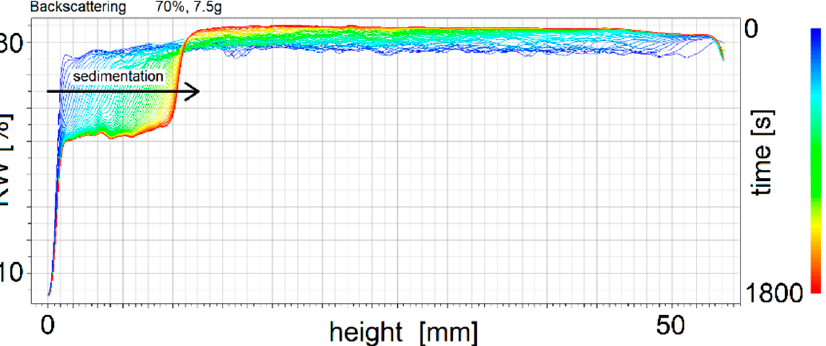
Figure 3. Changes in the backscatter signal over time as a function of test sample height for a 70% concentration emulsion (D 1 ), using 0.3 g/mL glass microspheres with diameter 300–400 μ m. In Figure 3, colored curves can be observed indicating the percentage of backscattered light along the sample height. The blue curve refers to the first scan. Subsequent curves in red refer to subsequent scans. The red curve refers to the last scan after 30 min. As can be seen in the graph presented in Figure 3 in the lower part of the sample (from 0 to about 10.5 mm), the values of RW decrease in time from about 78% to about 52%. These changes in values are indicative of the sedimentation process taking place. For glass microspheres deposited at the bottom of the cell, the reflected light value is lower than for emulsions. As can be observed, the height at which the RW value reached 52% was increasing. This height will be denoted in this work as h s and will determine the thickness of the sediment layer. Considering the upper part of the sample (above 11 mm), it can be observed that the RW values increase slightly with time. This means that the emulsion becomes more and more free of solid particles during the sedimentation process, and for pure emulsion, the RW values are the highest. Similar graphs were obtained for all studied systems. Since the growth of the sediment layer with time is an important parameter in the analysis of the sedimentation process, it was possible to read the changes in h s values with time from the graphs of the changes in backscattered light with height. This also allowed the calculation of changes in the average sedimentation velocity u over time. The average sediment phase build-up velocity was calculated using the